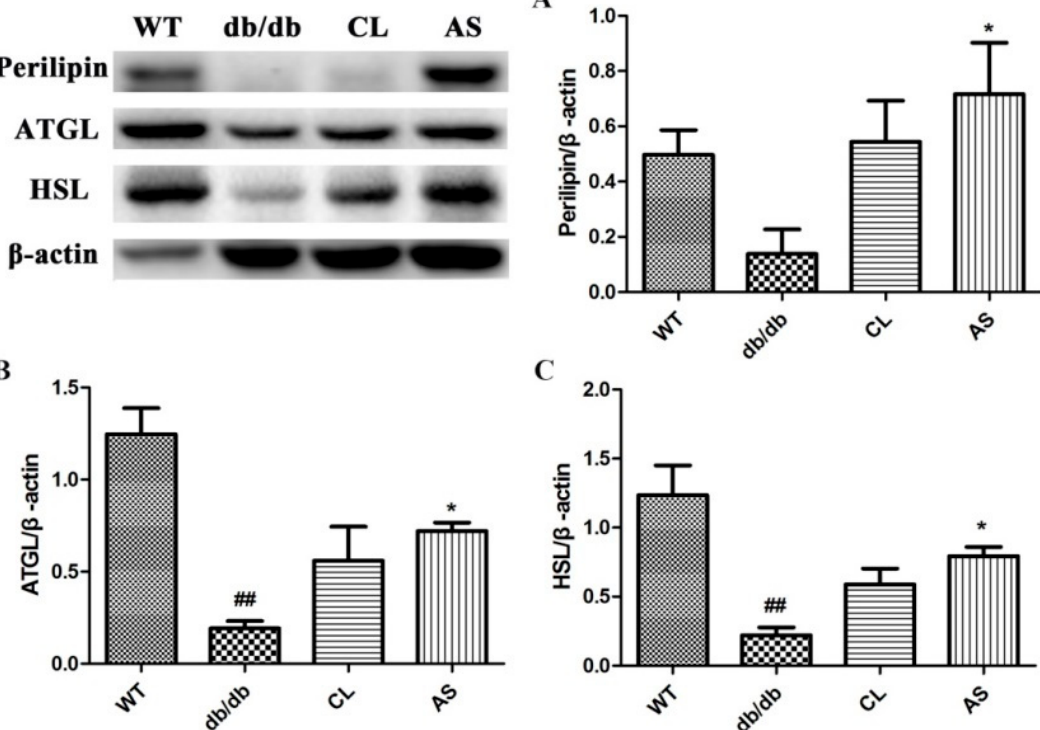
Figure 5. AS increased the expressions of lipid-metabolizing enzymes in adipose tissue. ( A ) perilipin; ( B ) ATGL; and ( C ) HSL protein expression in adipose tissue was analyzed by Western blot. Immunoblots are representative of five independent experiments; β -actin served as a loading control. Values are expressed as mean ± SEM of five mice. * p < 0.05 vs. the db/db group; ## p < 0.01 vs. the WT group.